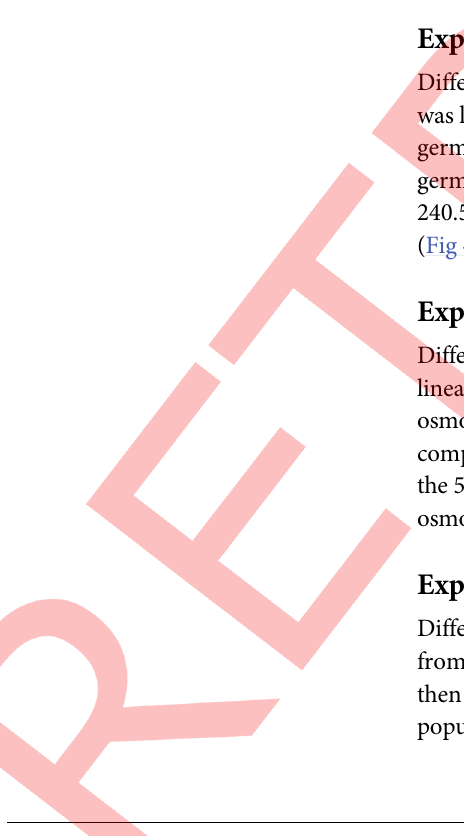
Fig 1. The influence of different photoperiods on seed germination percentage of ruderal and agricultural populations of Xanthium strumarium L.